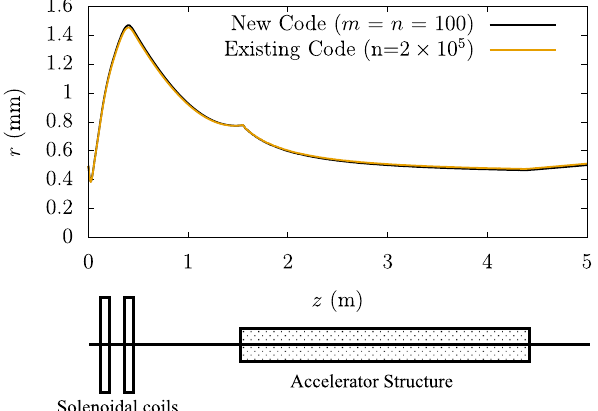
FIG. 14. Time evolutions of transverse rms beam size for low- emittance beam dynamics calculations for the SPring-8 rf gun injector system. The results for the new and existing codes are shown together.